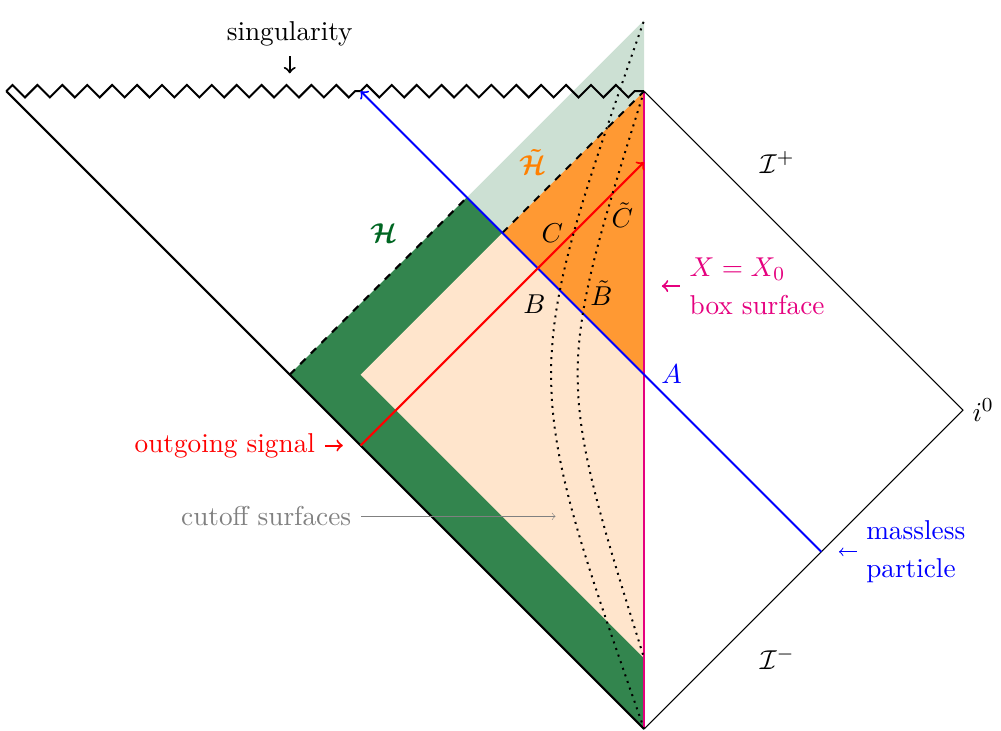
Figure 2 . Shockwaves for asymptotically flat dilaton gravity in a box. Spacetime is put in a box at X = X 0 . A is the intersection of the box surface with the shockwave generated by a massless particle of energy δM . The horizon H grows to ˜ H after the shock. Extrapolations of spacetime regions beyond their regime of validity are weakly colored. B ( ˜ B ) is the intersection of the shockwave with the initial (new) cutoff surface at time t 1 ( ˜ t 1 ). C ( ˜ C ) is the intersection of the outgoing signal